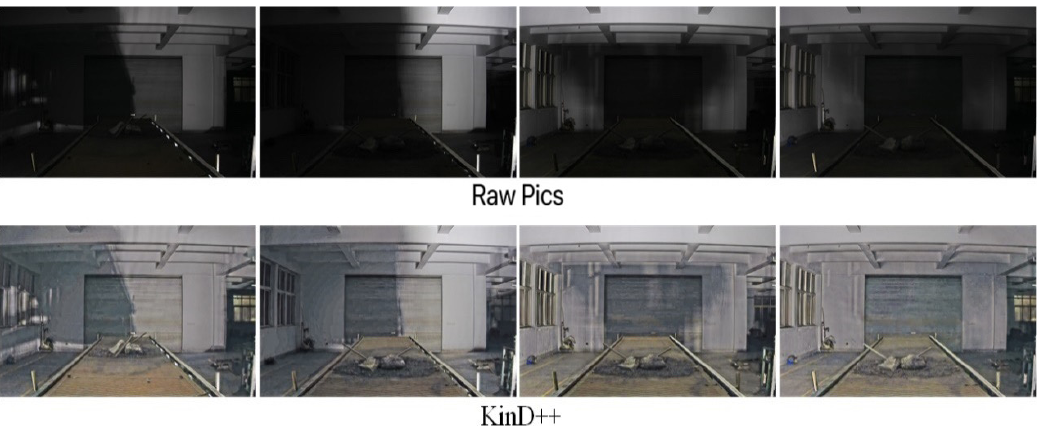
Figure 9. Enhancement of KinD++ algorithm on images in the dark.